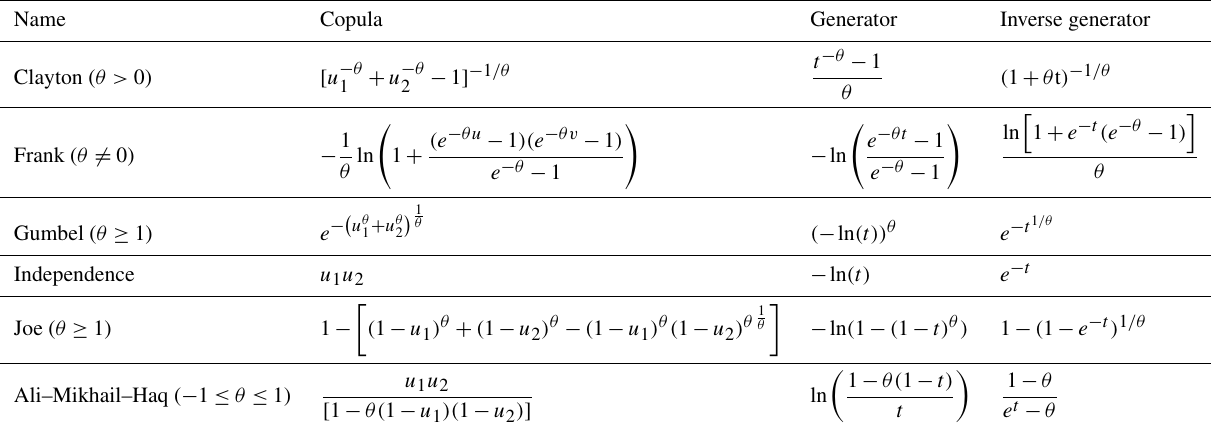
Table A1. Archimedean copulas. Name Copula Generator Inverse